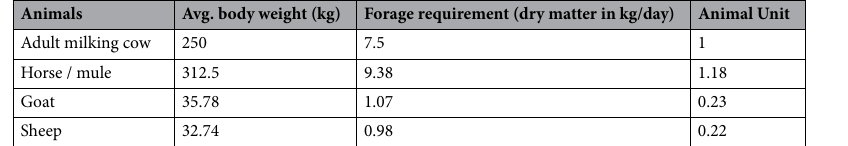
Table 7. Animal unit and forage